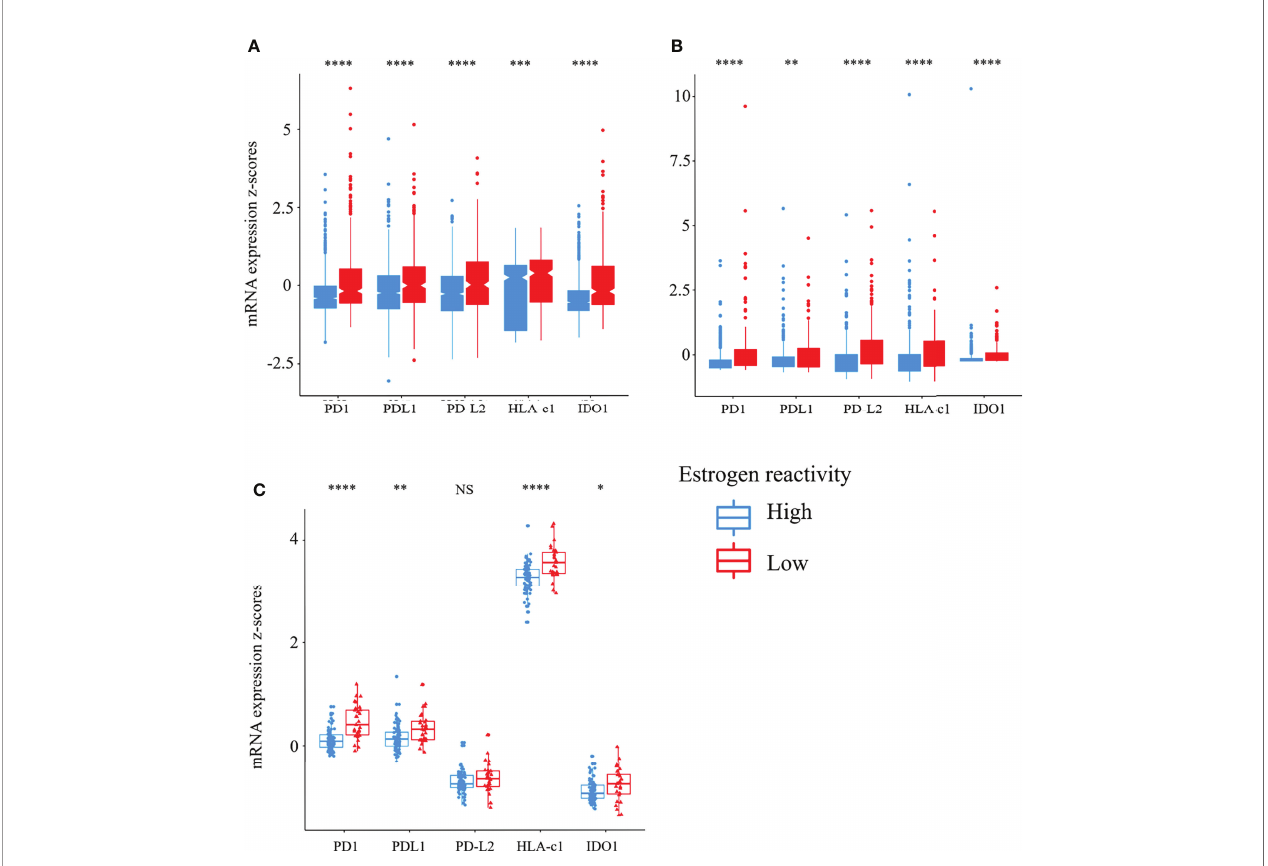
FIGURE 4 | Stimulatory and inhibitory factors of the CIC in the levels of estrogen reactivity. Box plots of the relationship between estrogen reactivity and stimulatory (HLA-A mRNA) or inhibitory factors (PD-1, PD-L1, PD-L2, and IDO1) of the CIC in METABRIC (A) and TCGA (B) and our cohort (C) were shown. **** means P < 0.0001, *** means P < 0.001, ** means P < 0.01, and * means P < 0.05. CIC, cancer immunity cycle; METABRIC, Molecular Taxonomy of Breast Cancer International Consortium; TCGA, The Cancer Genome Atlas; NS, not signi fi